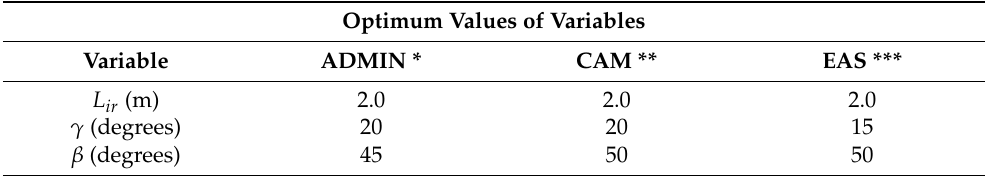
Table 2. Optimum obtained values for three variables of the optimization objective.